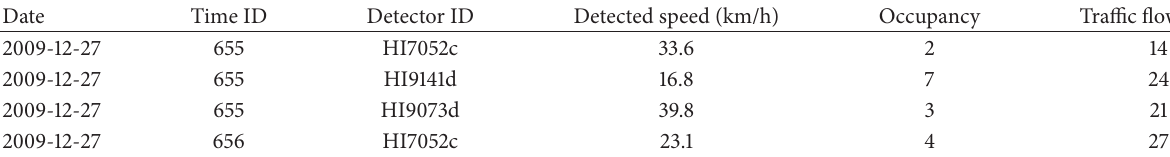
Table 1: Main fields of microwave detector data in Beijing.